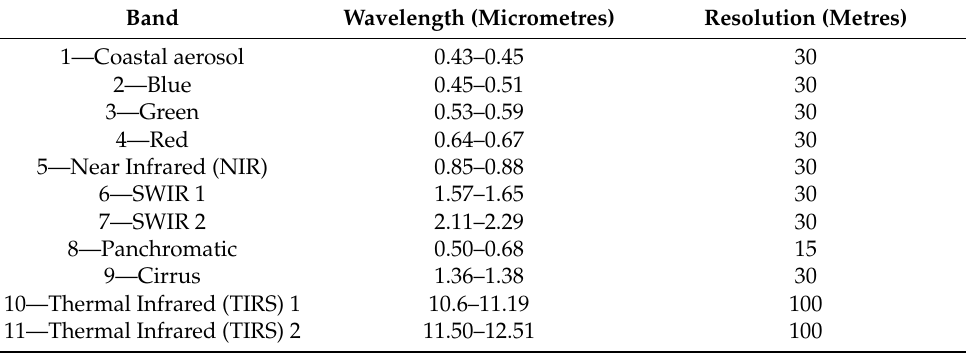
Table A2. Landsat 8 and 9 Operational Land Imager (OLI) and Thermal Infrared Sensor (TIRS) 2018 imagery (Data Taken from USGS